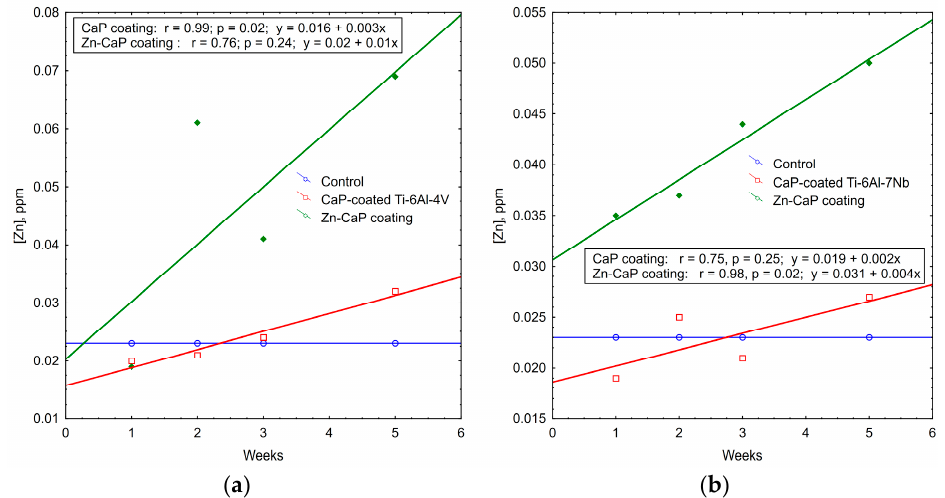
Figure 10. Regression lines of median Zn 2+ accumulation per week in extracts during 5-week immersion of ( a ) Ti–6Al–4V and ( b ) Ti–6Al–7Nb substrates with different CaP coatings in 0.9% NaCl